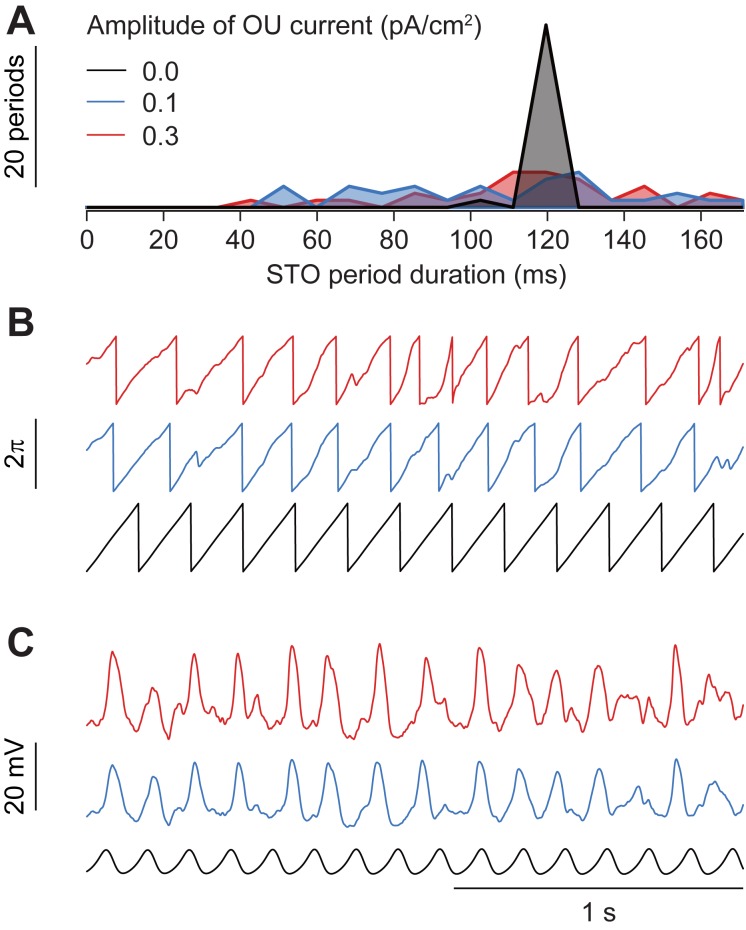
Significant variability of oscillatory periods induced by contextual input on oscillation period of a single model cell.(A) Distribution of inter-peak intervals for a single model cell under 5 s of contextual stimulus (OU current) of different amplitudes. To gauge period variability without introducing refractory periods, input levels were chosen for non-spiking subthreshold dynamics only. The unperturbed model cell (in black) produces regular periods, while weak levels of contextual input are sufficient to create substantial variability (red and blue). (B) Example traces of membrane potential and (C) phase for the single cell under perturbations, for the same random seed. Note that under contextual input there was substantial variation in periods, but similar STO periodicity despite different levels of input.